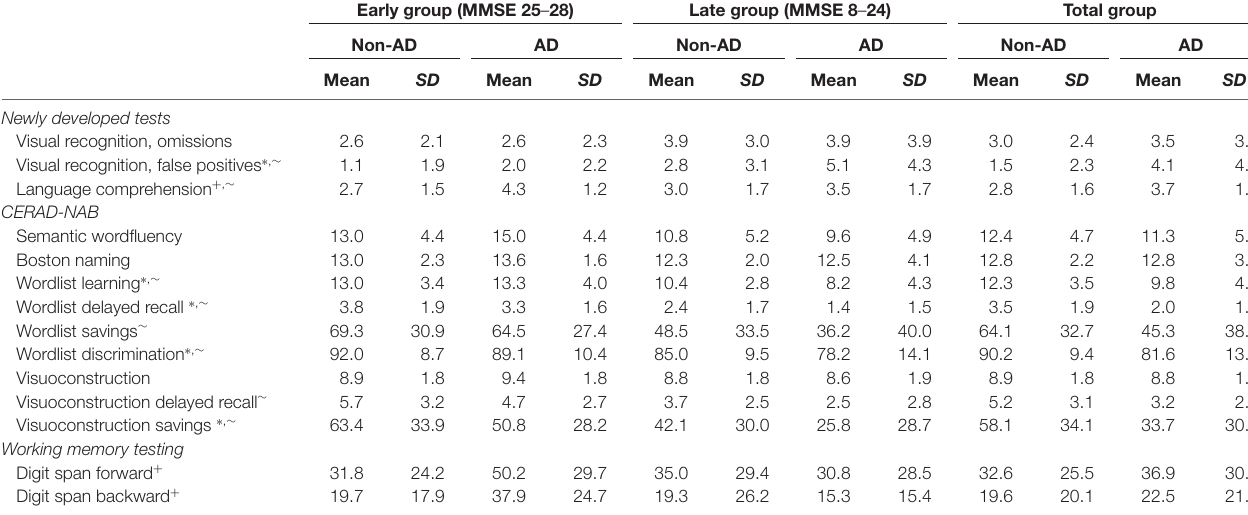
TABLE 2 | Neuropsychological test results of the patients’ groups.